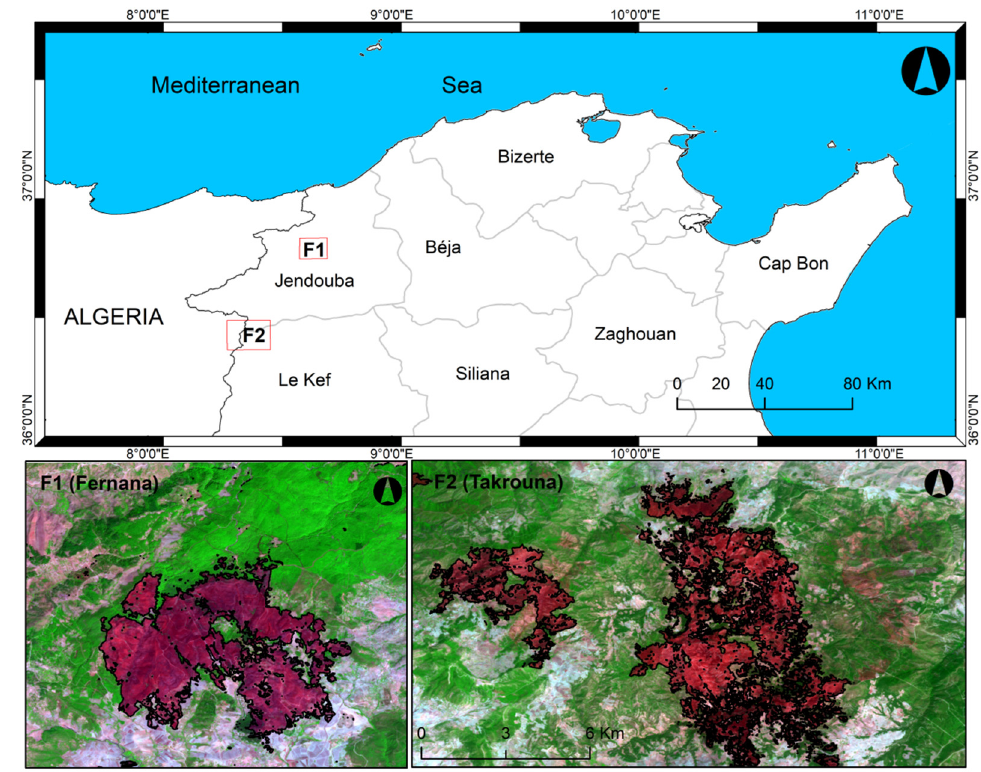
Figure 1. Location of the selected fires in Tunisia. Sentinel 2A false color images (red: band 12, green: band 8, blue: band 4) depicting the Fernana (F1) and Takrouna (F2) fire scars. The extent of each fire (black contour polygons in the bottom panels) was delineated by thresholding the RBR index. The Fernana (F1) fire occurred at 1:30 p.m. on 11 August 2021 in Fernana locality (Fernana delegation, Jendouba governorate). The fire lasted for two consecutive days and